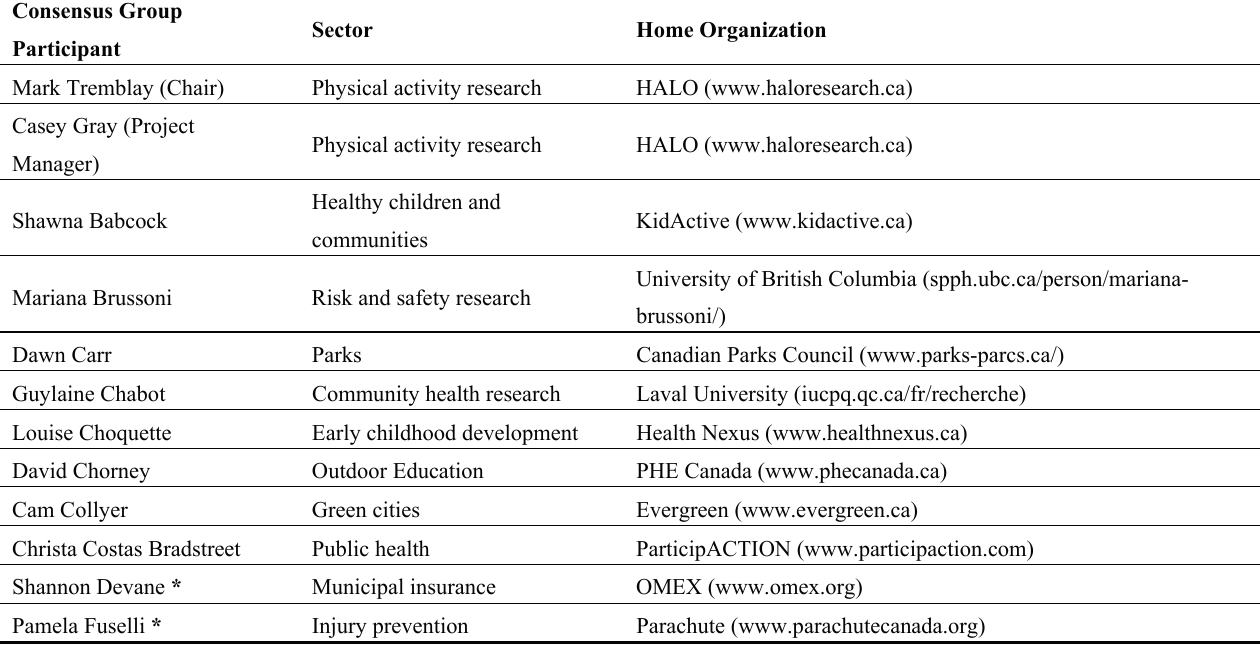
Table 2. Position Statement development consensus